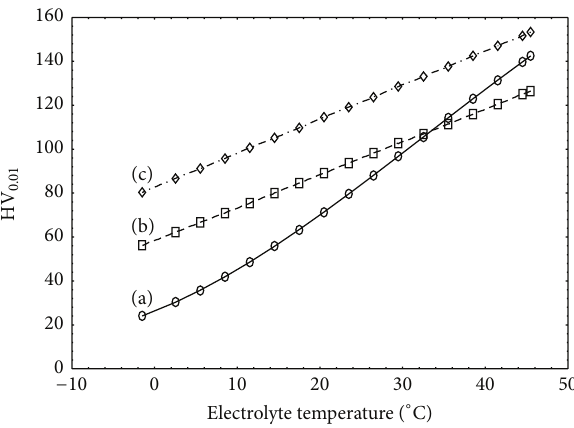
Figure 10: The dependence of the layer microhardness on the electrolyte temperature: c (H 2 SO 4 ) = 1.99mol ⋅ L −1 , c (C 2 H 2 O 4 ) = 0.06 mol ⋅ L −1 , U = 8.5 V, t = 20min. (a) 1A ⋅ dm −2 , (b) 3 A ⋅ dm −2 , and (c) 5 A ⋅ dm −2 .